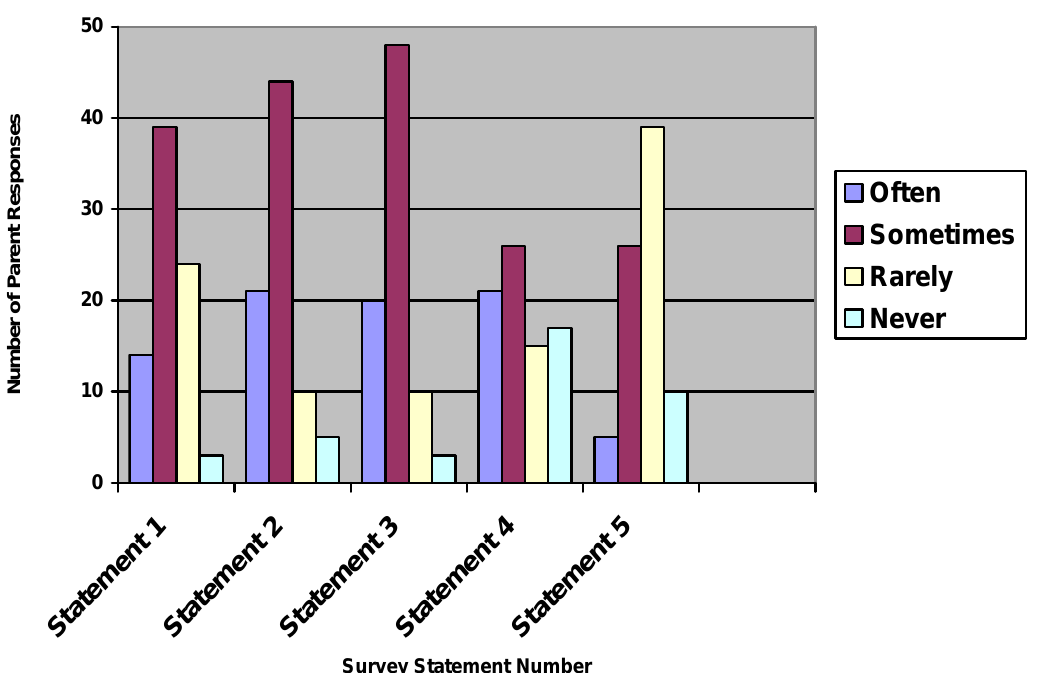
Figure 8. Parent Survey conducted after implementation of posting and communicating daily learning